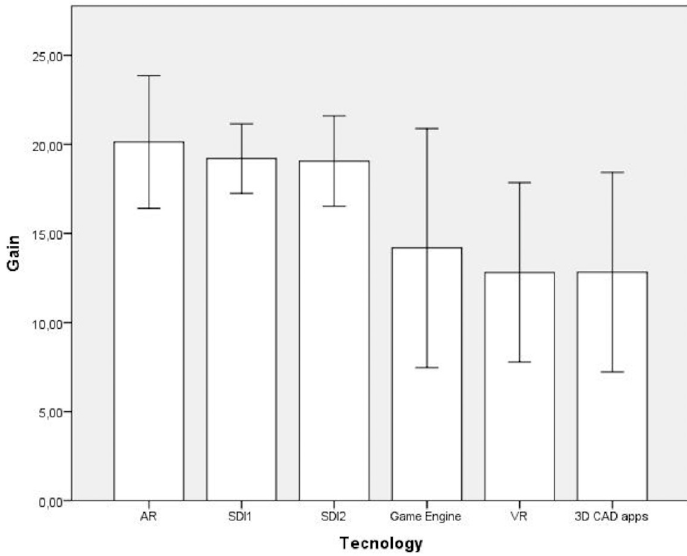
Figure 2. Mean gains as a function of Technology with 95% confidence intervals.